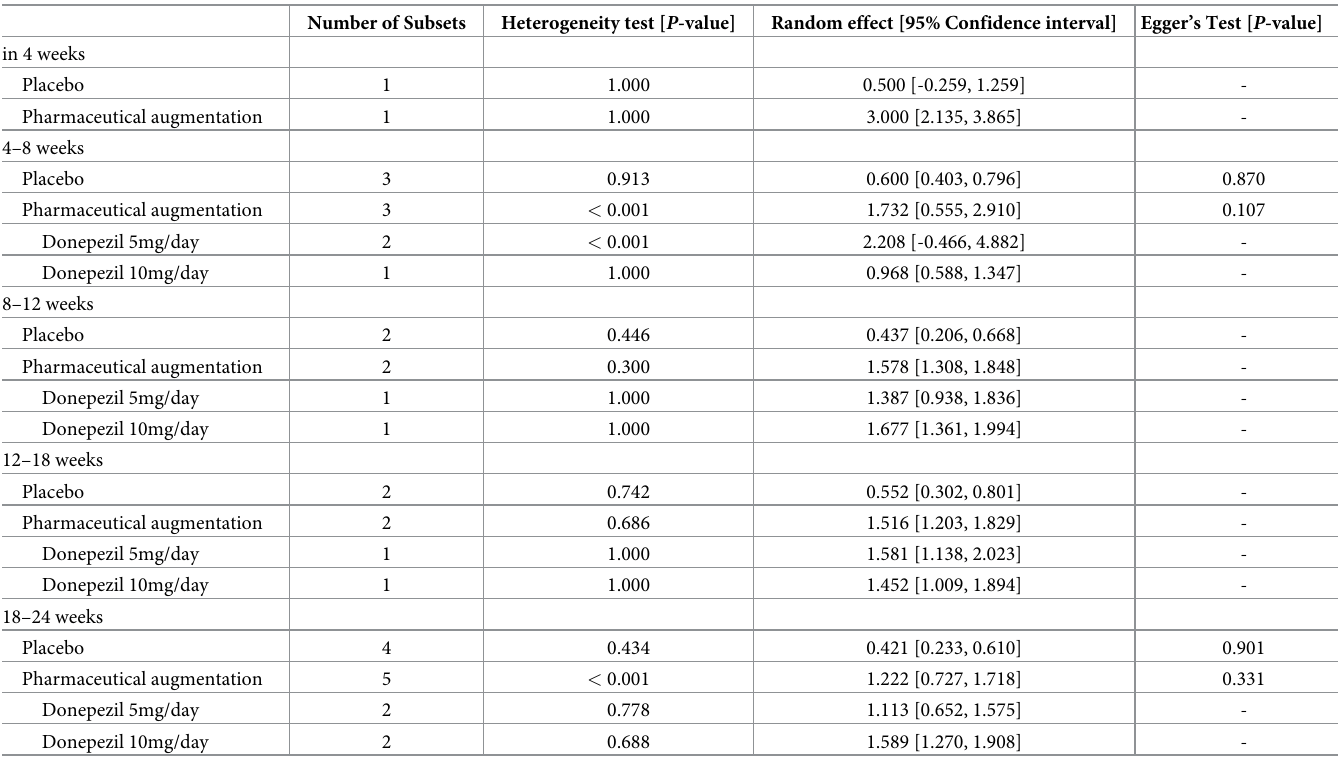
Table 2. The mean difference of MMSE score according to the pharmaceutical augmentation.